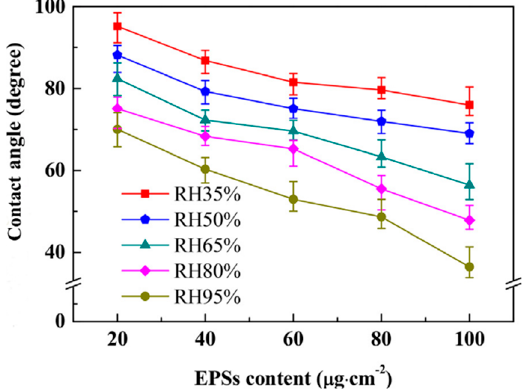
Figure 11. The relationship between the contact angle and EPS concentration.